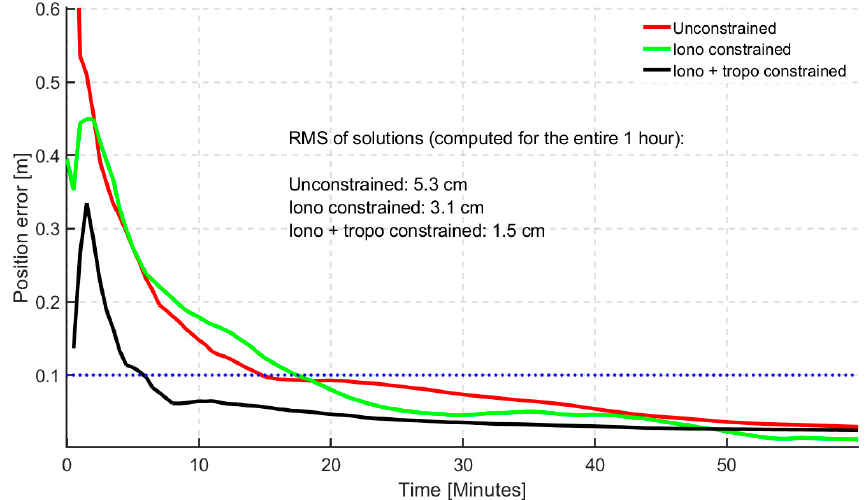
Figure 7. 95th percentile time series showing horizontal positional error (hourly) based on 24 hourly solutions for 40 stations for dual-frequency GREC processing mode. Blue dotted line represents the 10 cm convergence threshold.